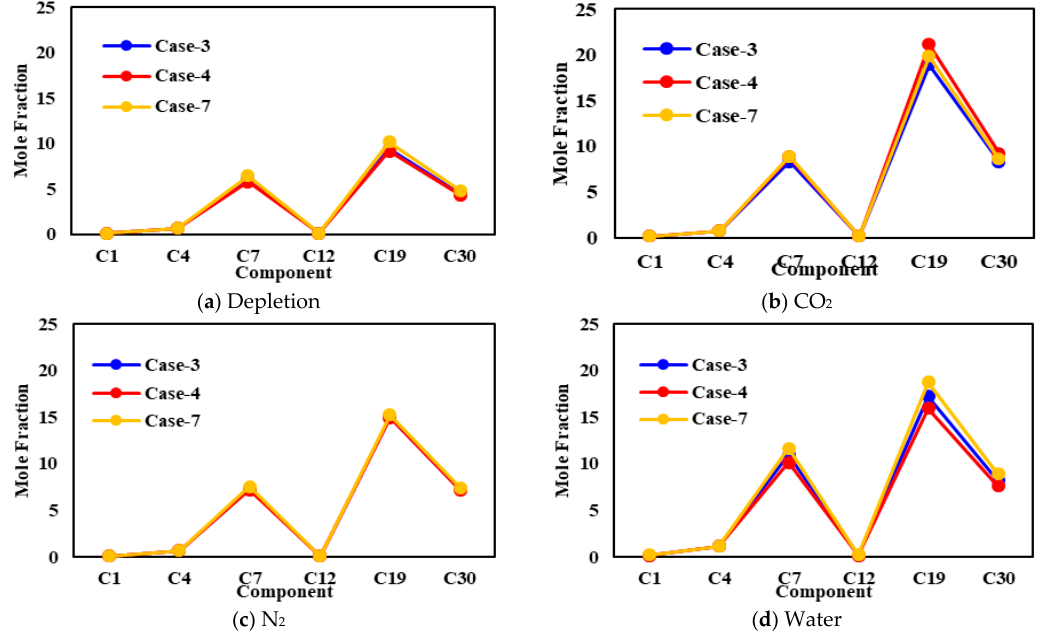
Figure 34. Production component comparison in different cases.